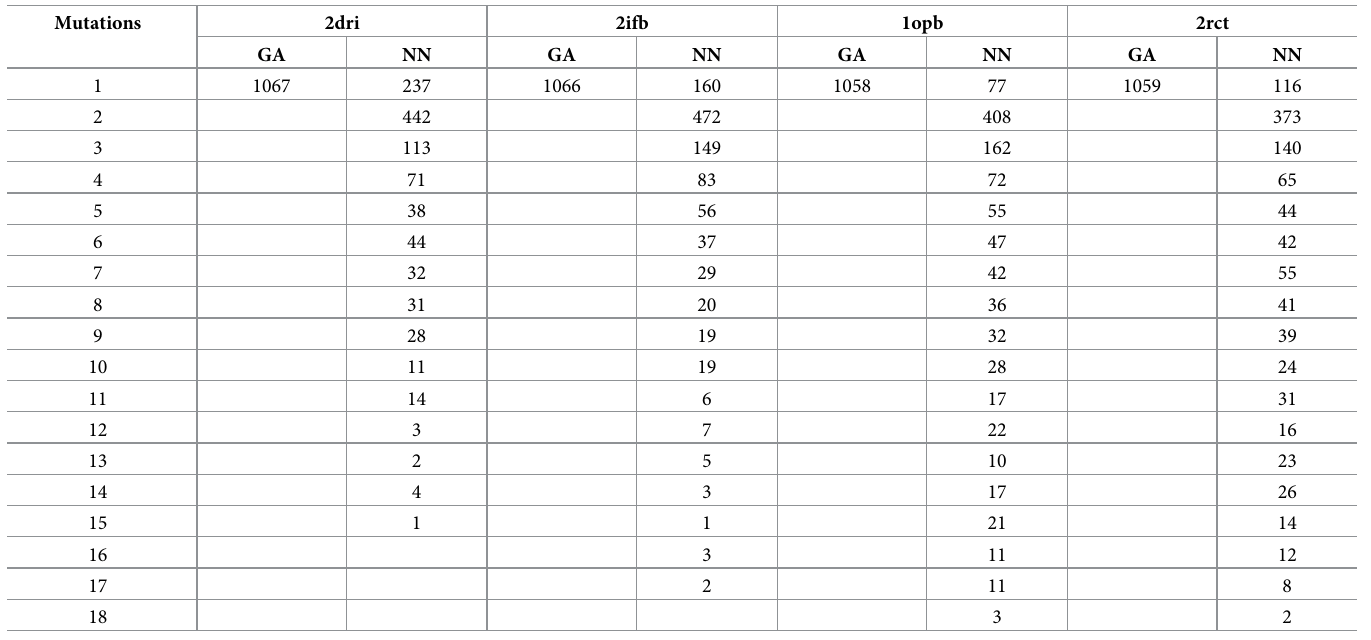
during the first 10 iterations. r